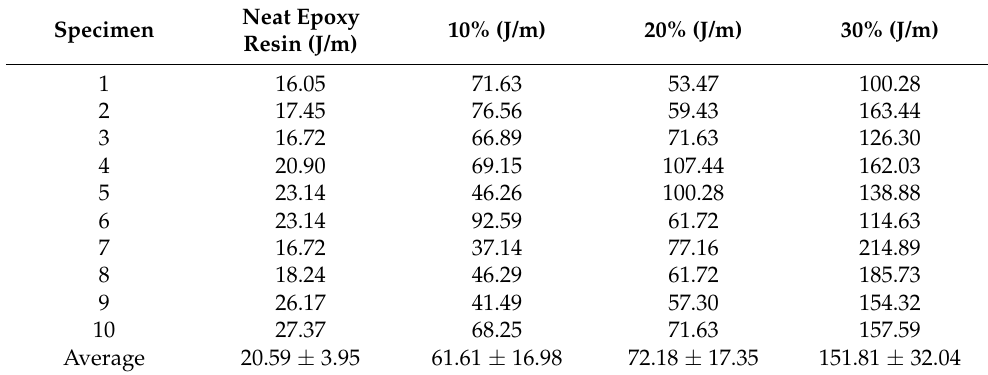
Table 1. Izod impact energy (J/m) for neat epoxy resin and caranan fiber reinforced composites. Specimen Neat Epoxy Resin (J/m)